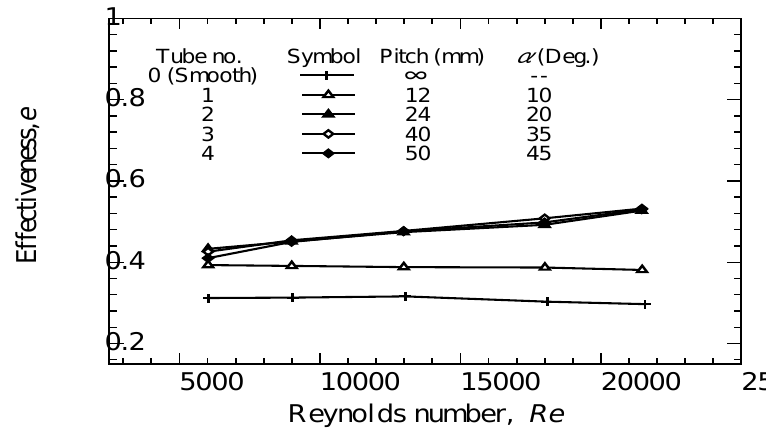
Figure 8: Variation of average effectiveness against Reynolds number for smooth tube and wire-coil inserted